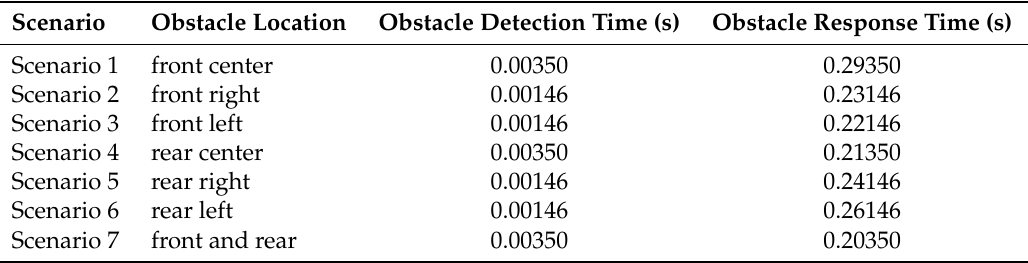
Figure 18. Obstacle avoidance algorithm testing results shows the robot stopping as an obstacle is detected by the ( a ) front middle sensor, ( b ) front right sensor, and ( c ) front and rear sensors. The detection and response times of each scenario are tabled in Table 1. Our system can respond within 0.3 s of being close to an obstacle by 60 cm from the front and rear sides and 30 cm from the left and right sides as measured in the lab. Table 1. Obstacles detection and response